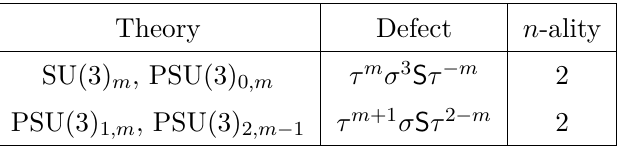
Table 3 . Non-invertible symmetries of su (3) at τ YM = i .